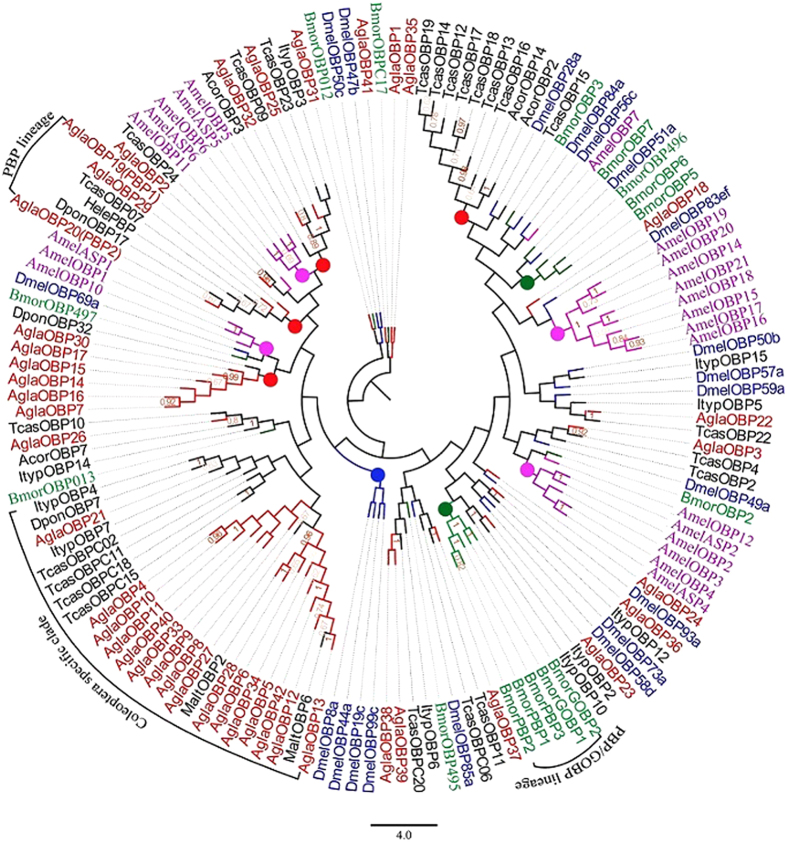
Neighbor-joining phylogenetic tree of candidate odorant-binding proteins (OBPs).The NJ phylogenetic analysis of OBPs of Anoplophora glabripennis (AglaOBP, red) was performed with reference OBPs of Monochamus alternatus (MaltOBP, dark), Anomala corpulenta (AcorOBP, dark), Dendroctonus ponderosae (DponOBP, dark), Ips typographus (ItypOBP, dark), Hylamorpha elegans (HelePBP, dark), Tribolium castaneum (TcasOBP, dark), Drosophila melanogaster (DmelOBP, Diptera, blue), Bombyx mori (BmorOBP, Lepidoptera, green), and Apis mellifera (AmelOBP, Hymenoptera, purple). The stability of the nodes was assessed by bootstrap analysis with 1,000 replications, and only bootstrap values ≥0.6 are shown at the corresponding nodes. The scale bar represents 4.0 substitutions per site.